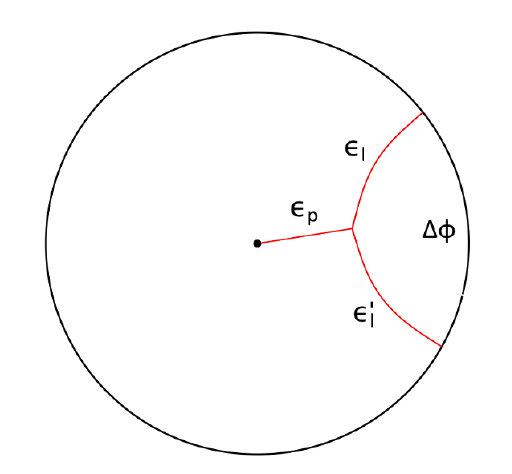
Figure 4 . The con(cid:12)guration of geodesics in the background of the conical defect in AdS 3 , which is dual to the semiclassical 4-point heavy-light conformal block on the sphere. The disc depicted is a slice of AdS 3 at constant time t = const. Polar coordinates ( (cid:26); (cid:30) ) are introduced on the